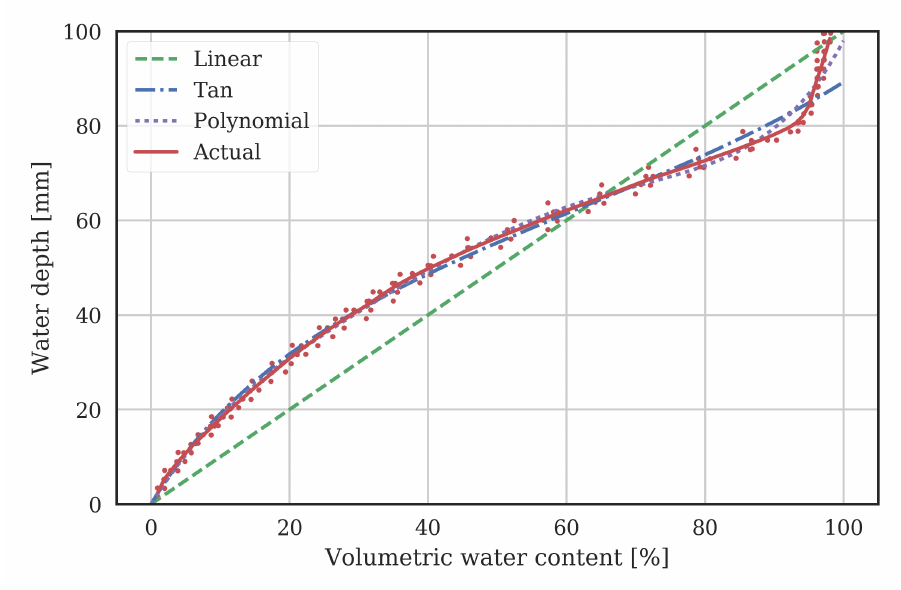
Figure 3. Water depth vs probe normalized VWC ( θ n MCP are shown as red points, and the mean over all these sensors as a solid red line. Other lines indicate the water depth calculated from θ n